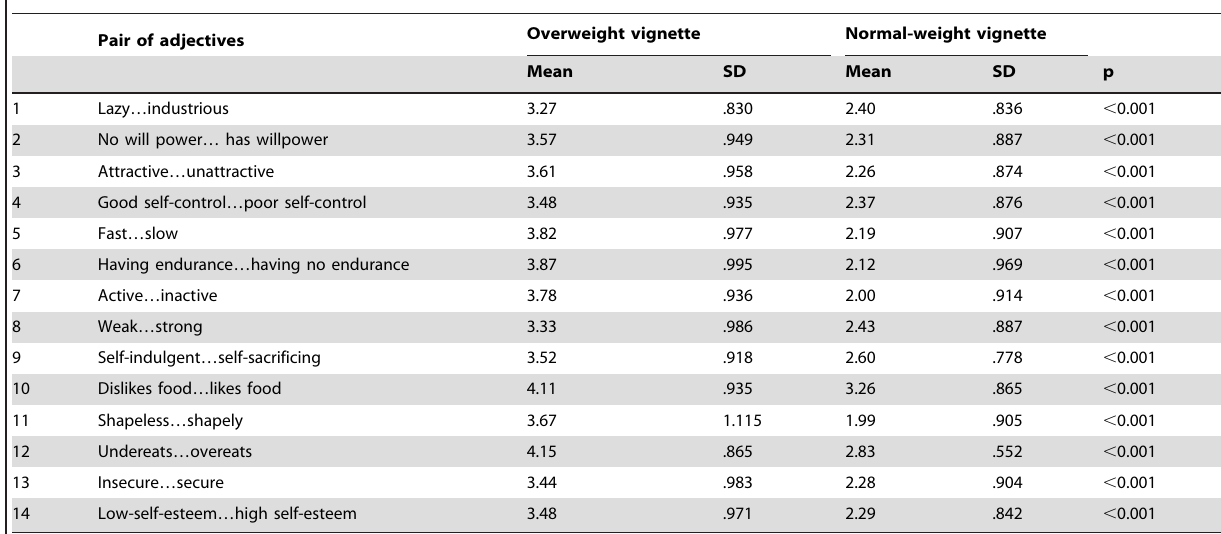
Table 3. Mean for each adjective pair of the Fat Phobia Scale.